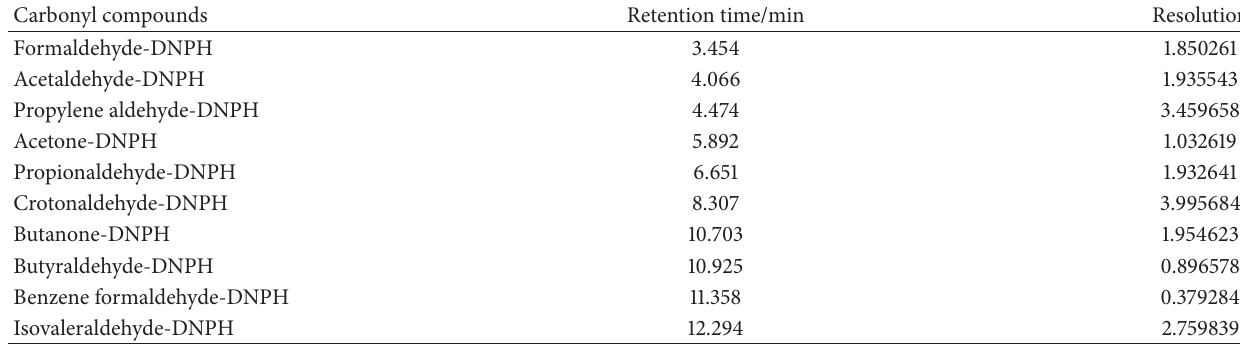
Table 3: The retention time and resolution of Agilent-C18